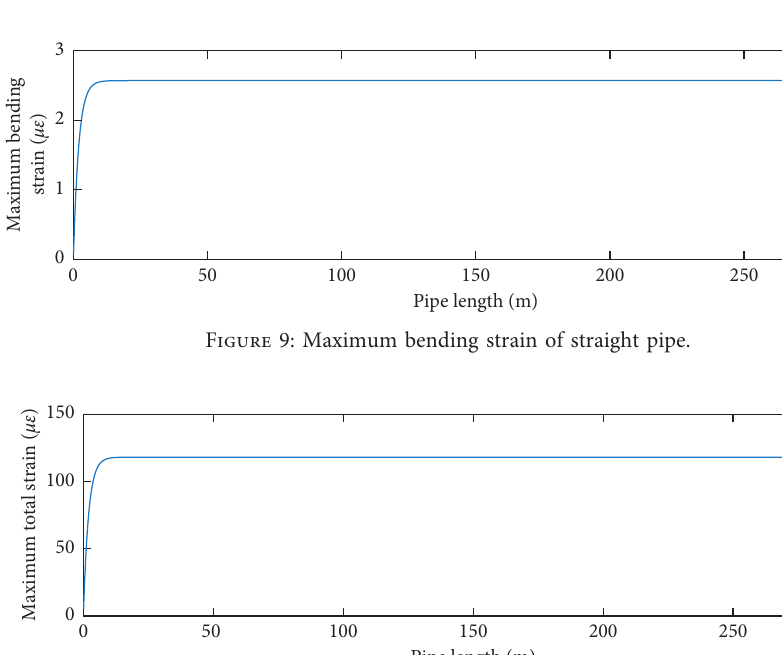
Figure 8: Maximum axial strain of straight pipe.